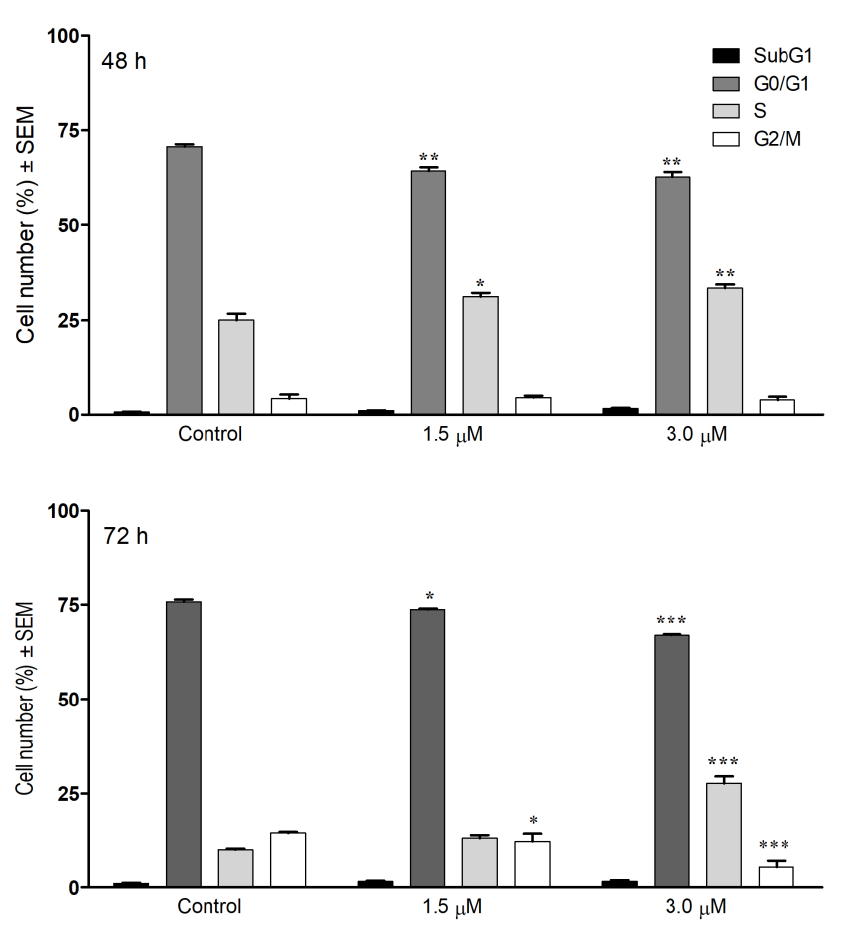
Figure 15. Cell cycle distributions of SiHa cells after treatment with compound 6 for 48 (upper pane) or 72 h (lower panel). Distribution of cell populations in different cell cycle phases. *, ** and *** indicate p < 0.05, p < 0.01 and p < 0.001, respectively, by means of one-way ANOVA followed by Dunnett’s post-hoc test.